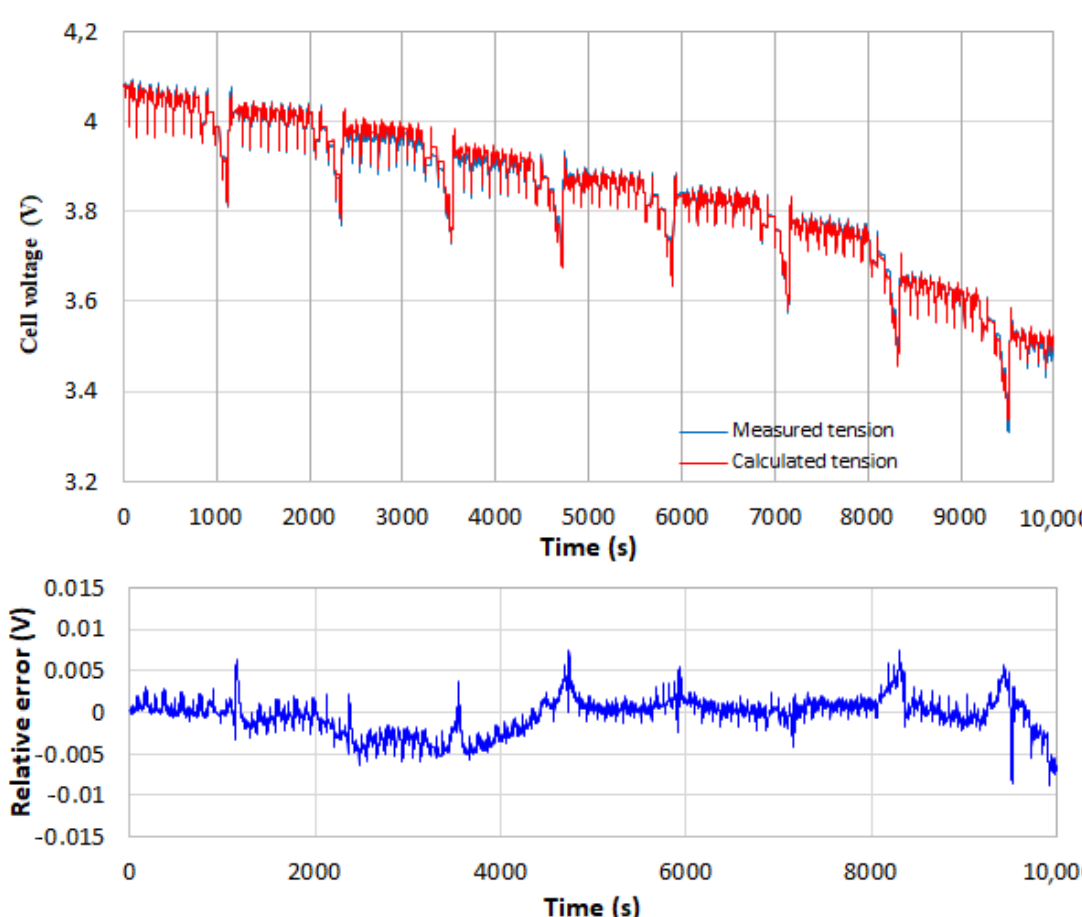
Figure 15. Comparison of the measured and calculated cell voltages. The Thevenin model used de- pends not only on the cell temperature but also on its SOC.